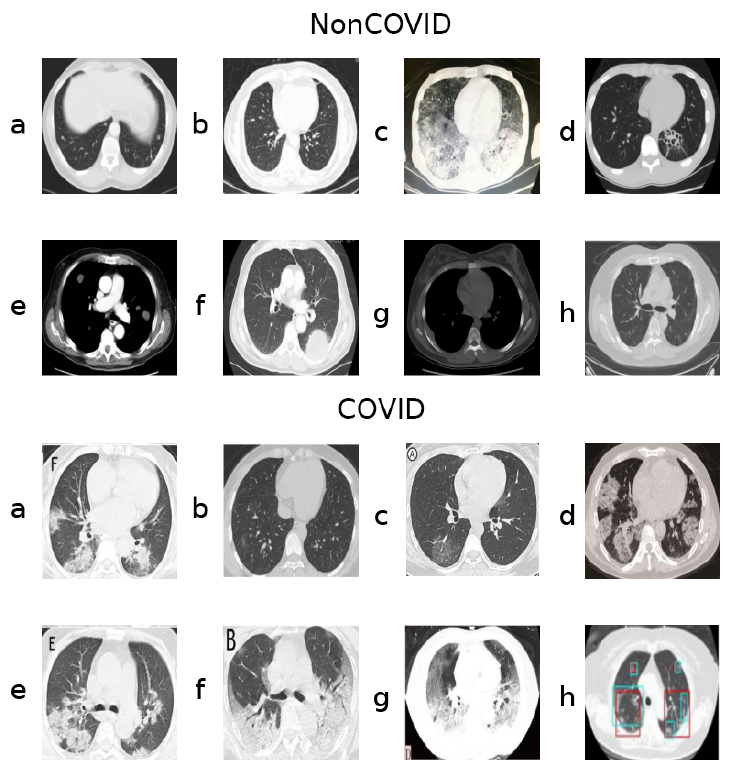
Figure 1. Samples from the two classes (NonCOVID and